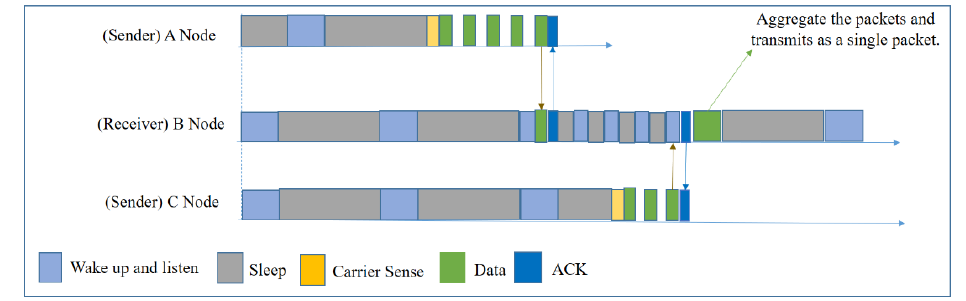
Figure 15. Packet transmission in ORD [12].